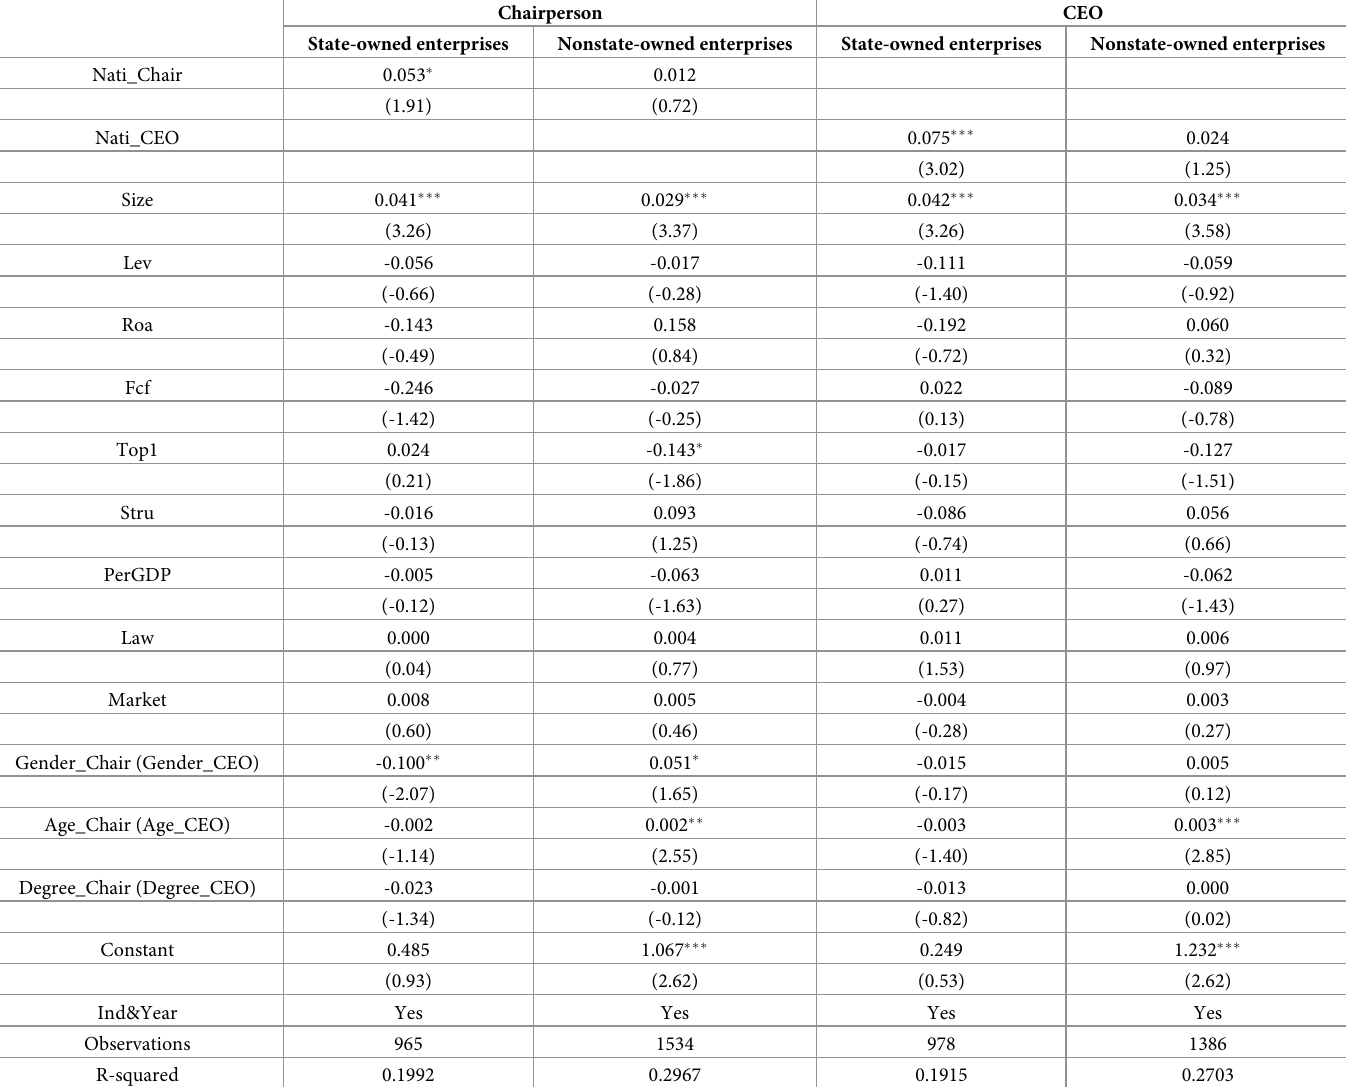
Table 13. Nature of property rights, senior executive home bias and employee social